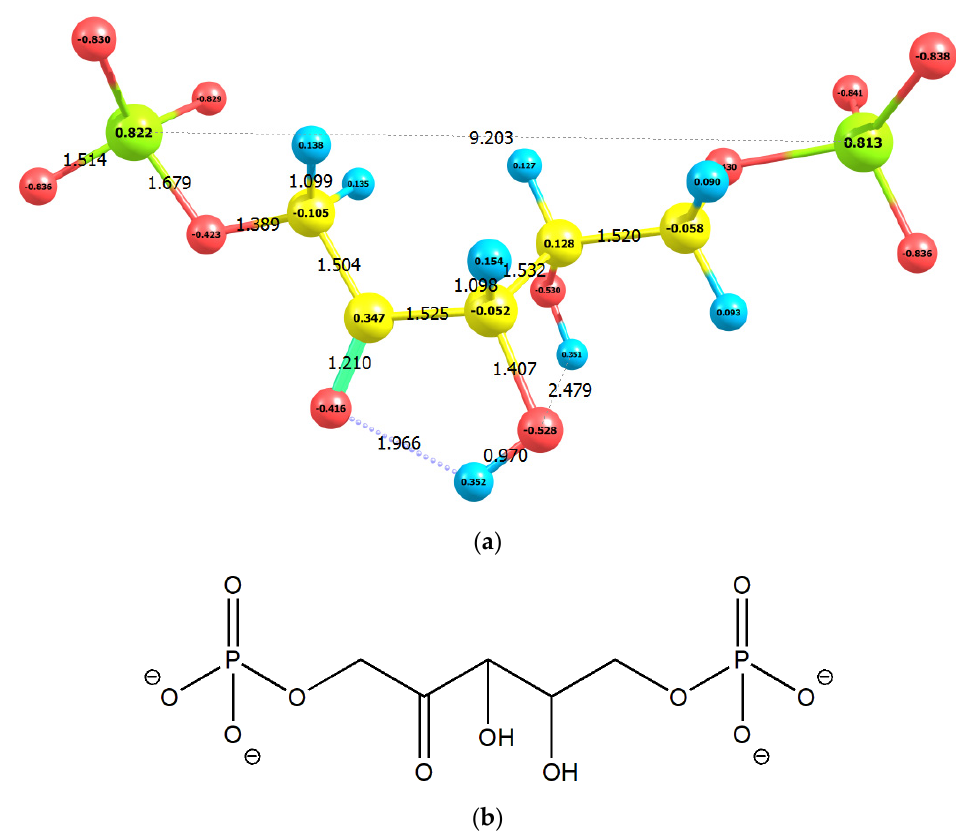
Figure A1. ( a ) The calculated geometric and electronic structure of ribulose-1,5-bisphosphate (RuBP); Q = − 4, M = 1, E 0 = − 46,437.91 eV, G 0 = − 46,434.57 eV. Hessian has negative frequencies: − 31.54, − 7.59 (cm − 1 ). ( b ) The scheme of 2,3-dihydroxy-4-oxopentane-1,5-diyl diphosphate.